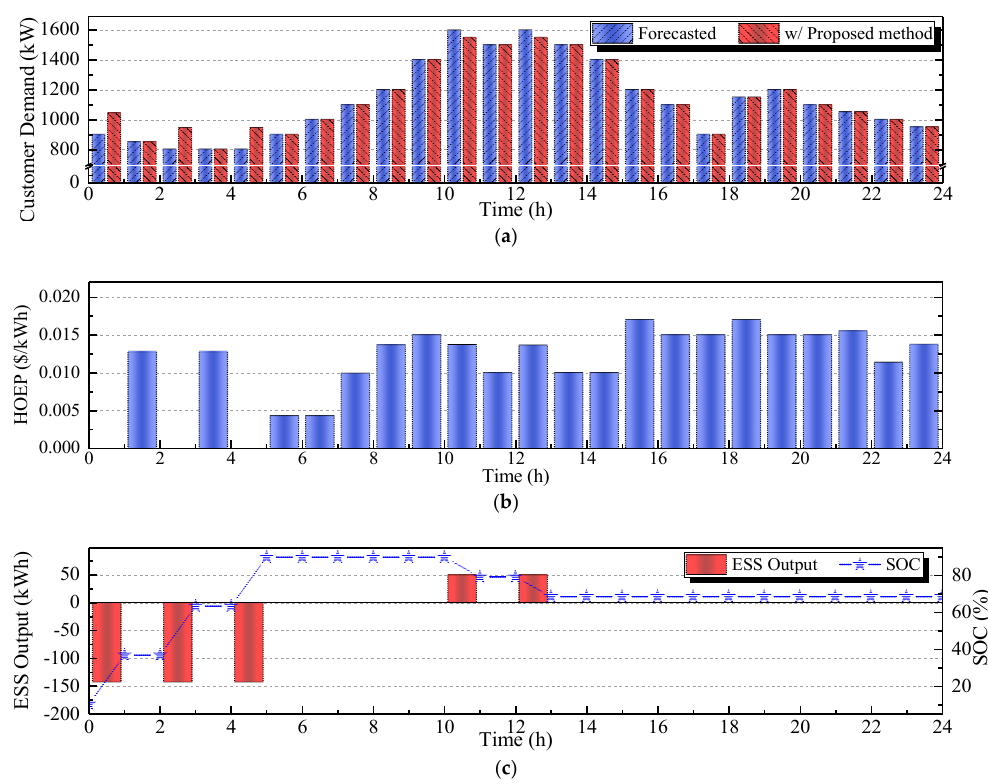
Figure A5. Results of Case 4: ( a ) Customer demand; ( b ) Forecasted HOEP; ( c ) Scheduled output and SOC of the ESS.